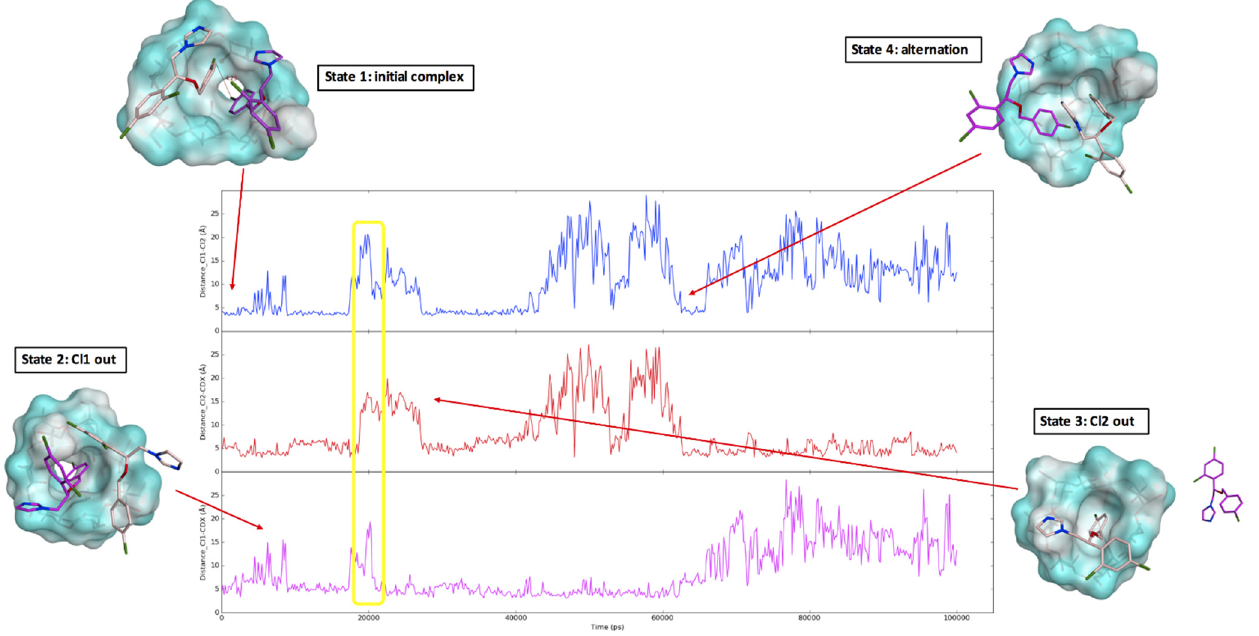
Figure 5. Molecular dynamic simulation results. The three graphs show the distance between the two chlorine atoms from the mono ‐ chloro phenyl ring of the two drugs (Cl1 and Cl2, blue line) and the distance between each chlorine atom and a CD central oxygen atom (Cl1 ‐ CDX, purple line, Cl2 ‐ CDX, red line). Four different states were observed during the simulations: state 1, a 2:1 complex in which the three monitored distances were constant; state 2, in which Eco ‐ 1 (Cl1) was released from the cyclodextrin (with increases in the Cl1 ‐ CDX (purple line) and Cl1 ‐ Cl2 (blue line) distances); state 3, in which Eco ‐ 2 (Cl2) was released from the cyclodextrin (with increases in the Cl2 ‐ CDX (red line) and Cl1 ‐ Cl2 (blue line) distances); state 4: alternation between the two econazole molecules occupy ‐ ing the cyclodextrin cavity (in this specific moment of the simulation, Eco ‐ 2 was approaching the cyclodextrin (decrease in Cl2 ‐ CDX distance—red line), while Eco ‐ 1 was slowly coming out (increase in the Cl1 ‐ CDx distance—purple line)). The yellow circle highlights a brief simulation instance in which the two econazole molecules were both outside of the cyclodextrin cavity. Distance (Y axis) was measured in Å, time (X axis) in ps. Econazole carbon atoms are in pink (Eco ‐ 1) and purple (Eco ‐ 2). HP ‐β‐ CD is represented as a molecular surface. Water molecules from the simulation environ ‐ ments have been removed for the clarity of the image. 3.4. Antifungal Activity The MIC data for the four fungal strains were found to be 141 μ g/mL for both Fusarium semitectum and Fusarium solani, and 283 μ g/mL for both Scolecobasidium tshawytschae and Bipolaris hawaiiensis (mean of three determinations). To determine poten ‐ tial efficacy, these figures were considered in relation to corneal volume. The volume of porcine corneas was determined as the difference between the native and dried (vacuum oven) weights of excised porcine corneas ( n = 6), where the difference was water loss (g/cornea) and the equivalent of the amount of mL per cornea (mL/cornea)—this was found to be 0.19 mL. Table 2 shows factors for the (econazole) delivered using the different drug delivery platforms at 6 h in relation to the (econazole) required to attain the MIC of the four fungal species. With 21.66 μ g of econazole delivered to the cornea, the drops of the saturated solution achieved the least satisfactory result, producing sub ‐ MIC levels at × 0.81 Fusarium